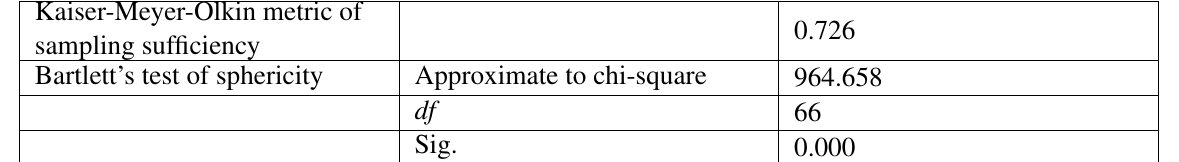
Table 3 Sampling moderation values and Bartlett’s test